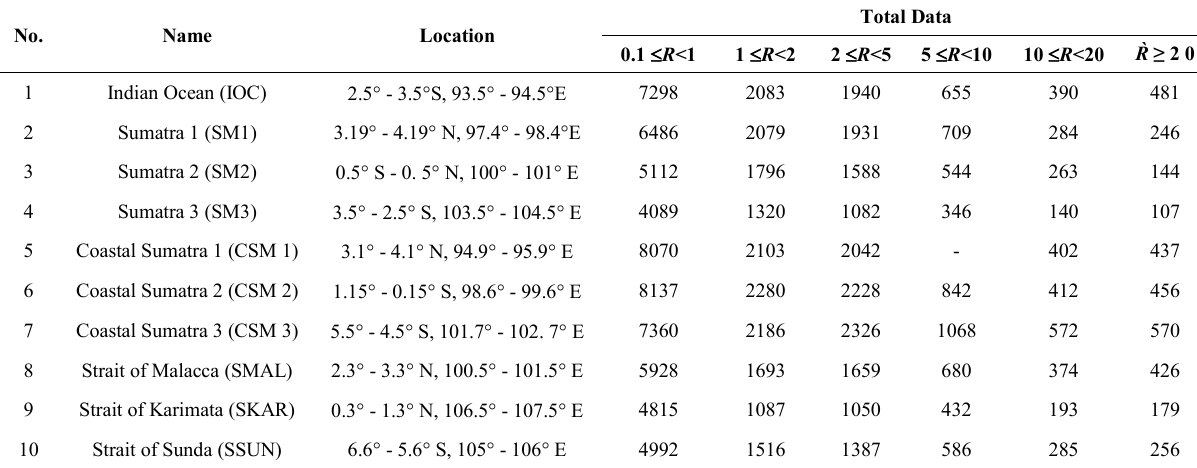
Table 2. Distribution of data for several locations of convective rain from GPM